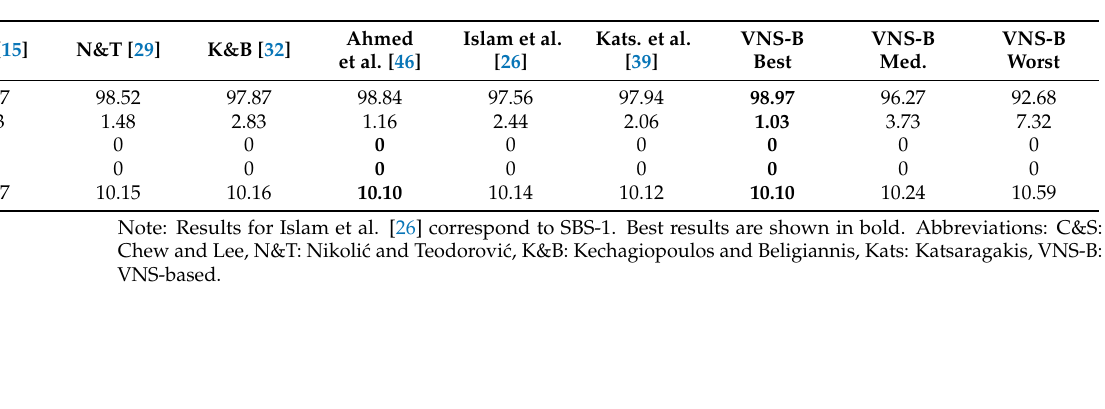
Figure 5. Best network with 6 routes.